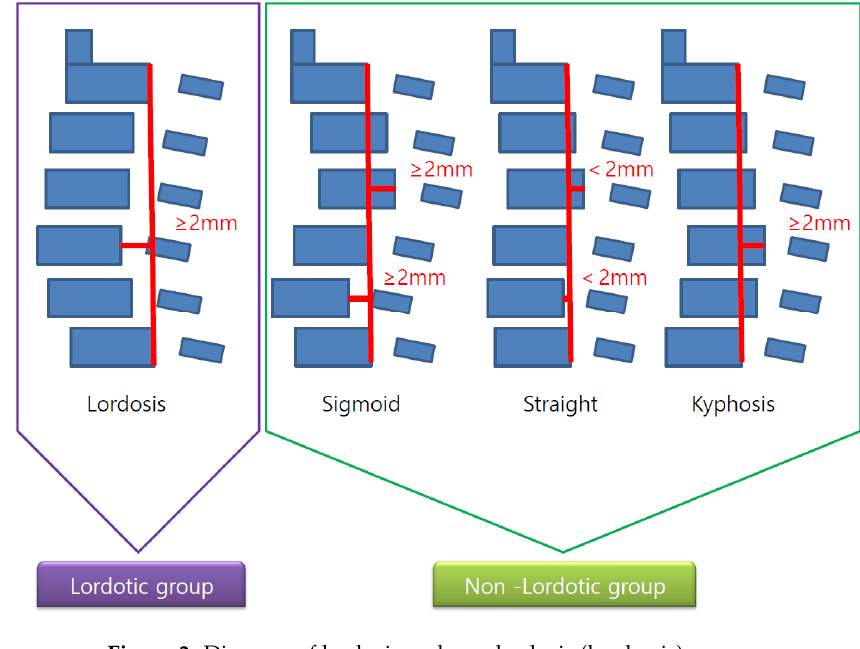
Figure 3. Diagram of lordosis and non-lordosis (kyphosis) groups.